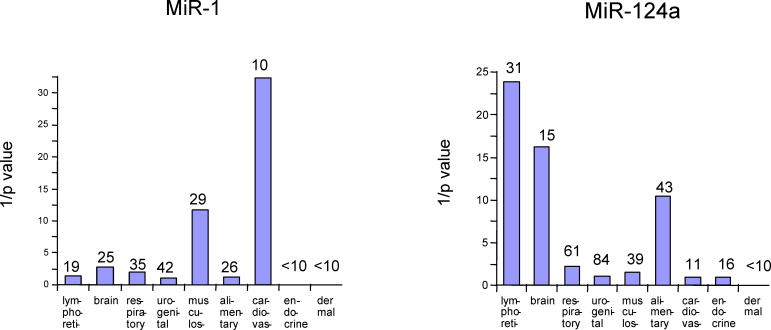
Inversed p-Value of Differential EST-Based Expression of Targeted Isoforms Between a Given Tissue Class and All Other Tissue Classes Combined (Student test, one-way)Numbers on top of bars indicate total numbers of targeted genes for which EST coverage was sufficient in this tissue class for both isoforms. No p-value was computed for tissue classes where less than ten genes were represented. Top-level tissue class “nervous” was replaced here by “brain” to avoid contamination by libraries from the peripheral nervous system.